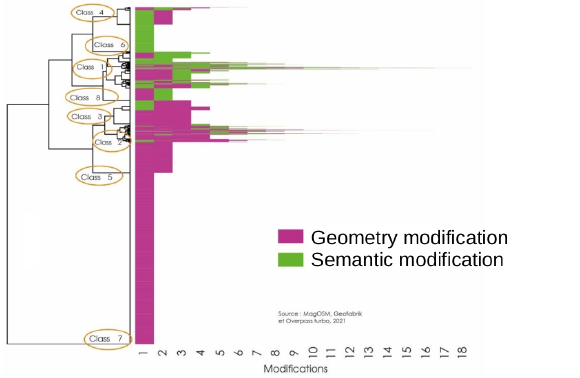
Figure 5. Carpet of sequences for the ”buildings” dataset, with a typology of two modifications.